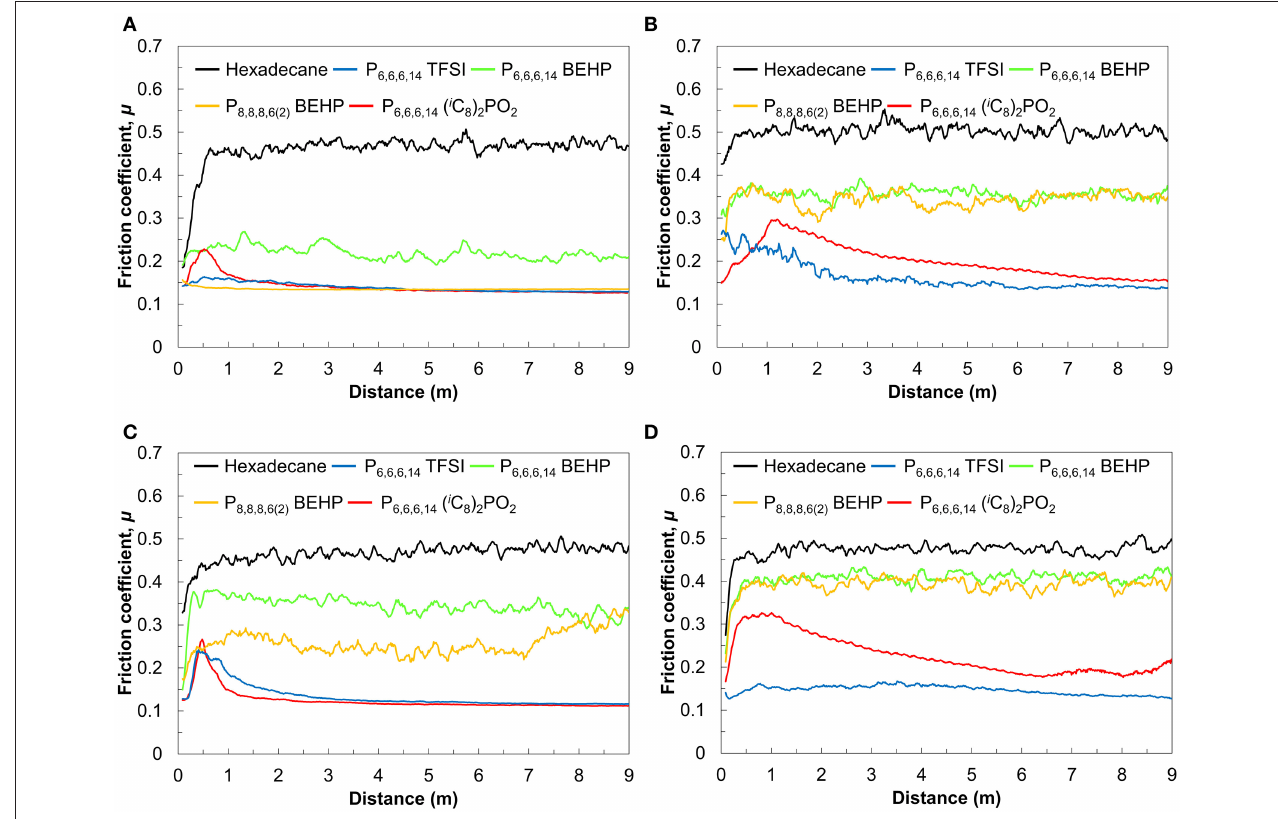
FIGURE 1 | Friction coefficient as a function of sliding distance at (A) 25 ◦ C and 5N, (B) 25 ◦ C and 10N, (C) 60 ◦ C, and 5N, (D) 60 ◦ C and 10 N.